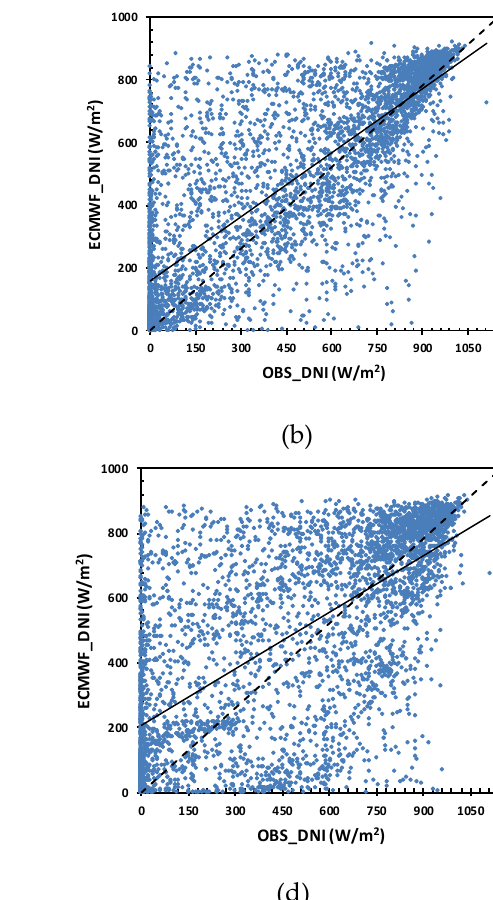
(b) Figure 2. Example of four consecutive days of observed (red line) and forecasted (blue line) hourly mean DNI in Évora starting at ( a ) 1 August 2017 00:00 and ( b ) 27 November 2017 00:00. The IFS/ECMWF forecasts have similar behavior to that of observational DNI for the two selected cases, with a fairly good agreement, especially in the case of August (Figure 2a). Figure 2b